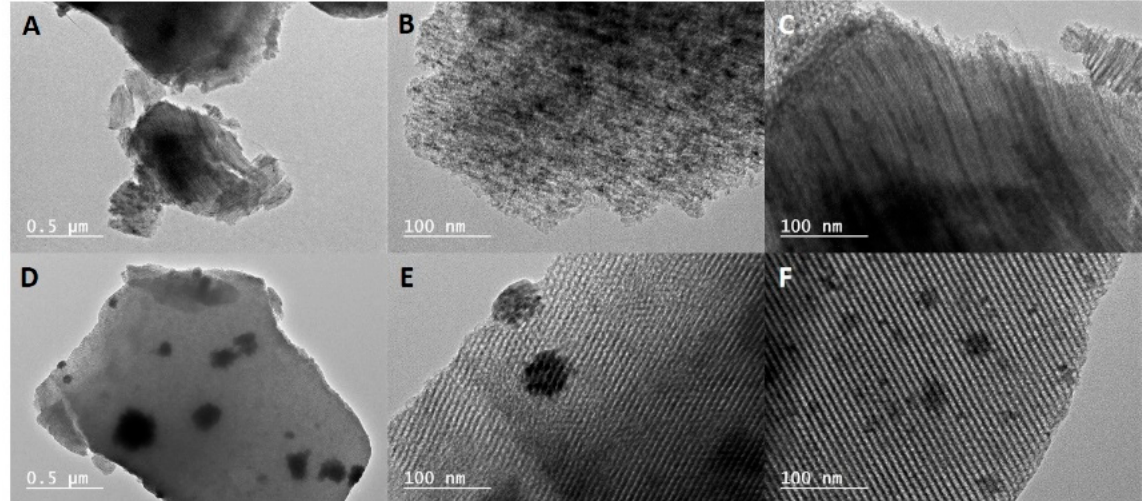
Figure 3. TEM images of Co:Ce (1:0.5) catalyst before ( A – C ) and after ( D – F ) reaction.